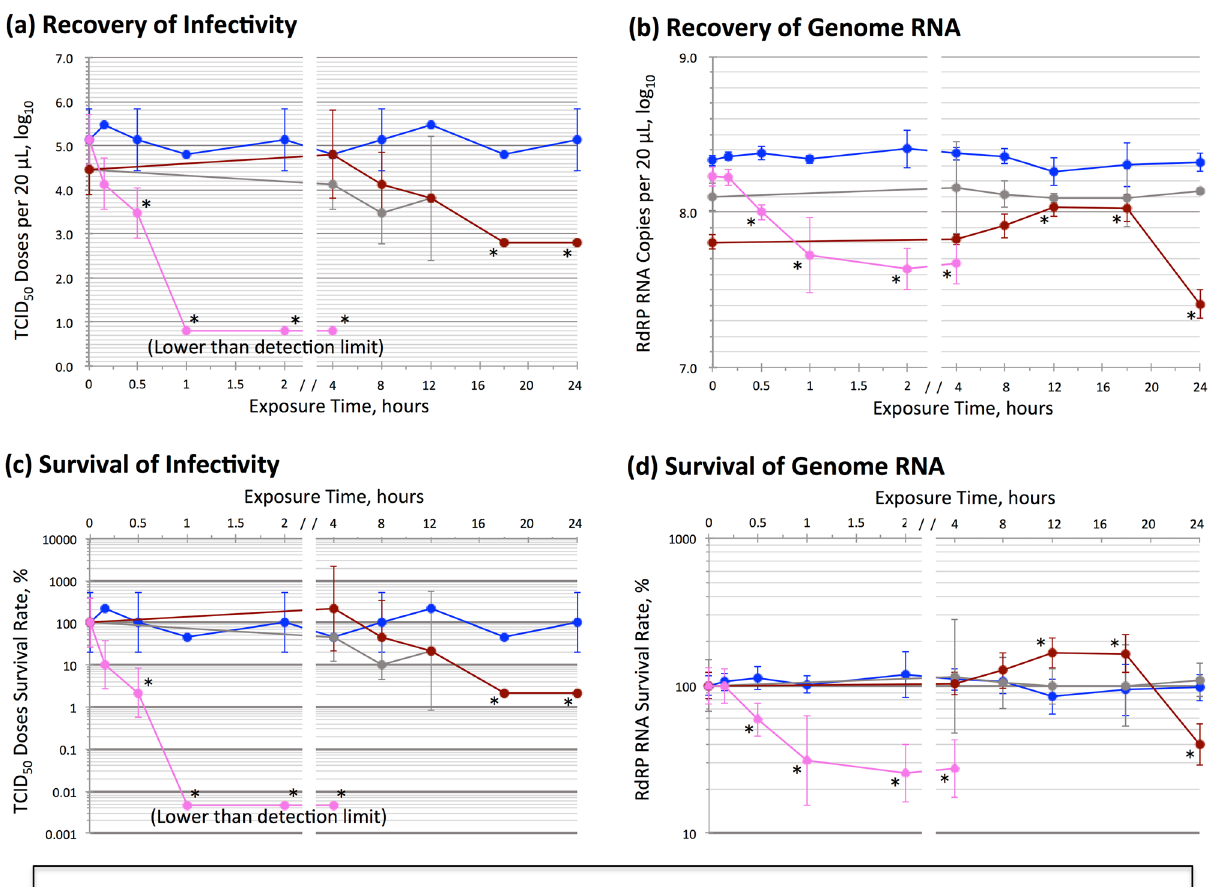
Figure 4. Inactivation of SARS-CoV-2 infectivity on CuNP/paint-coated stainless steel surfaces. An aliquot of 20 µL of virus dilution was applied on the test surface and covered by a circular glass slip of 1.13 cm in diameter foaming a cylindrical shape of 1 cm 2 base area by 0.2 mm height and placed inside a class II safety cabinet at 24 °C with relative humidity of 40–50% for various times. Then, the virus suspensions were retrieved in test tubes, titrated for infectivity in cell culture, and subjected to RT-PCR for RdRP RNA to estimate the copy number of the genomic RNA. ( a ) Recovery of infectivity. Infectivity doses of TCID 50 per 20 µL in log10 were plotted for exposure times. ( b ) Recovery of genome RNA. RdRP RNA copy numbers per 20 µL in log10 were plotted. ( c ) Survival of infectivity. The percentages of the recovered infectivity at various times to that at 0 h were plotted. ( d ) Survival of genome RNA. The percentages of the recovered RdRP RNA copy number at various times to that at 0 h were plotted. ( a – d ) Pink circle and connecting line: on CuNP/paint-coated stainless steel surface; Russet: on paint-coated surface; Gray: on uncoated surface; Brue: control in plastic tube. *: The decrease or increase from the value at 0 min was statistically significant ( P <